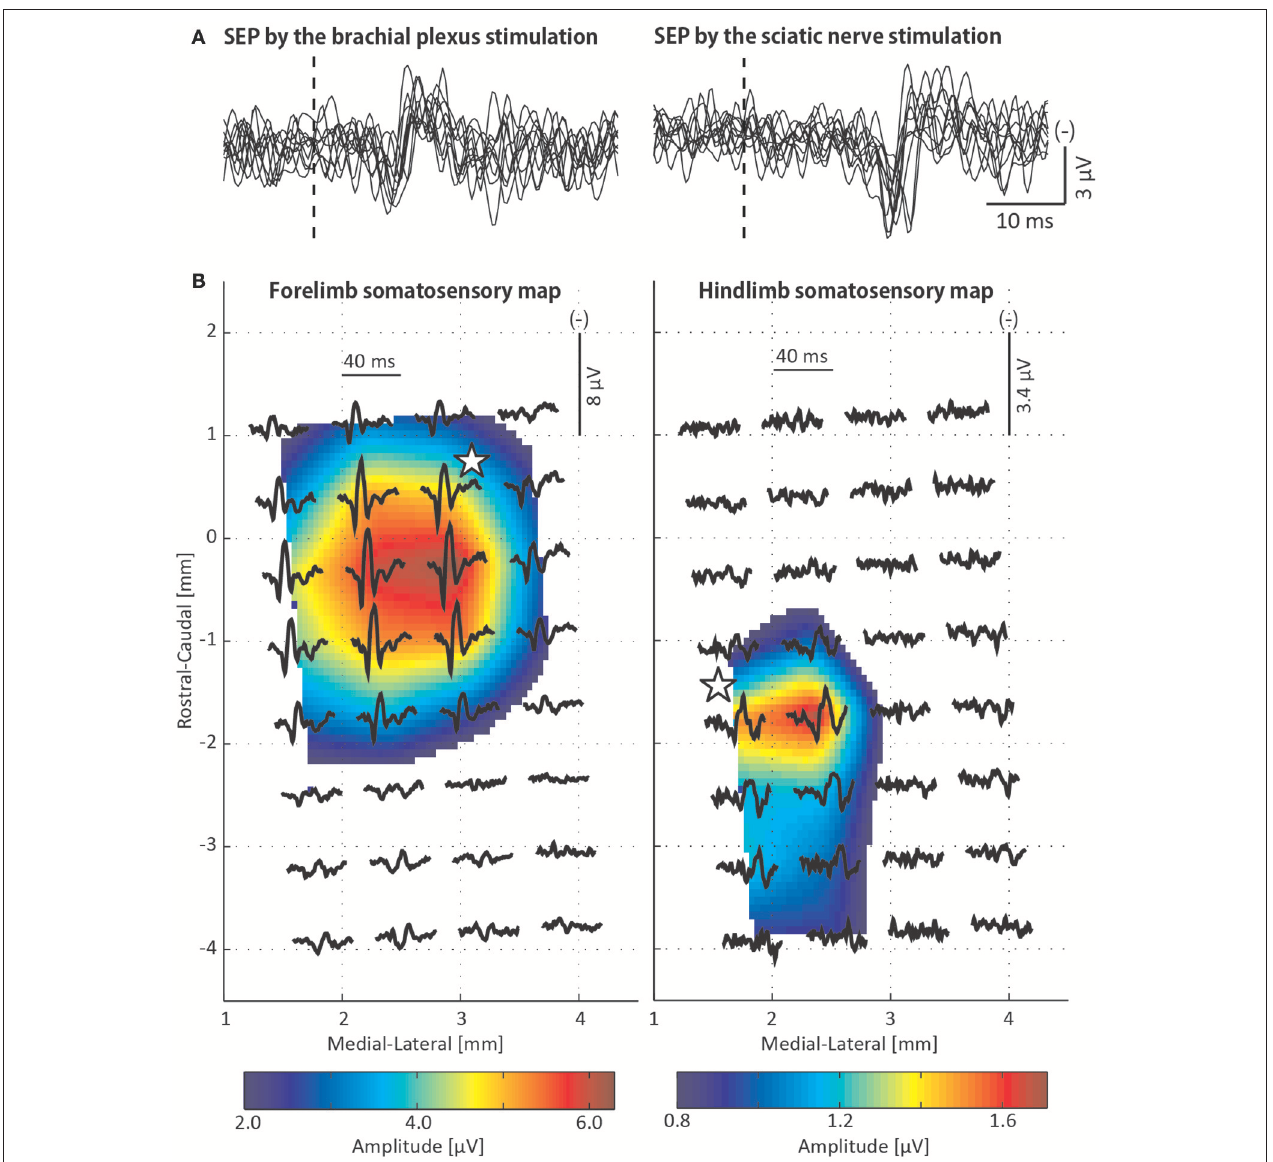
FIGURE 6 | Somatosensory evoked potential (SEP) recordings. (A) Ten overlaid SEP traces recorded from a single µ ECoG electrode that was repeatedly used for cortical stimulation. Vertical dotted line reflects the timing of the peripheral nerve stimulation. (B) Forelimb and hindlimb somatosensory maps that were composed of the SEPs elicited by the stimulations to the brachial plexus and sciatic nerve, respectively. Waveforms represent the average of 200 SEP traces recorded from each electrode. A somatosensory map was constructed using peak-to-peak amplitudes between initial positive and negative peaks of the SEP and spatially interpolated. The white star is the ECR/soleus motor hotspot where the lowest MT was observed in Figures 3A,G . The origin of the map corresponds to the position of the